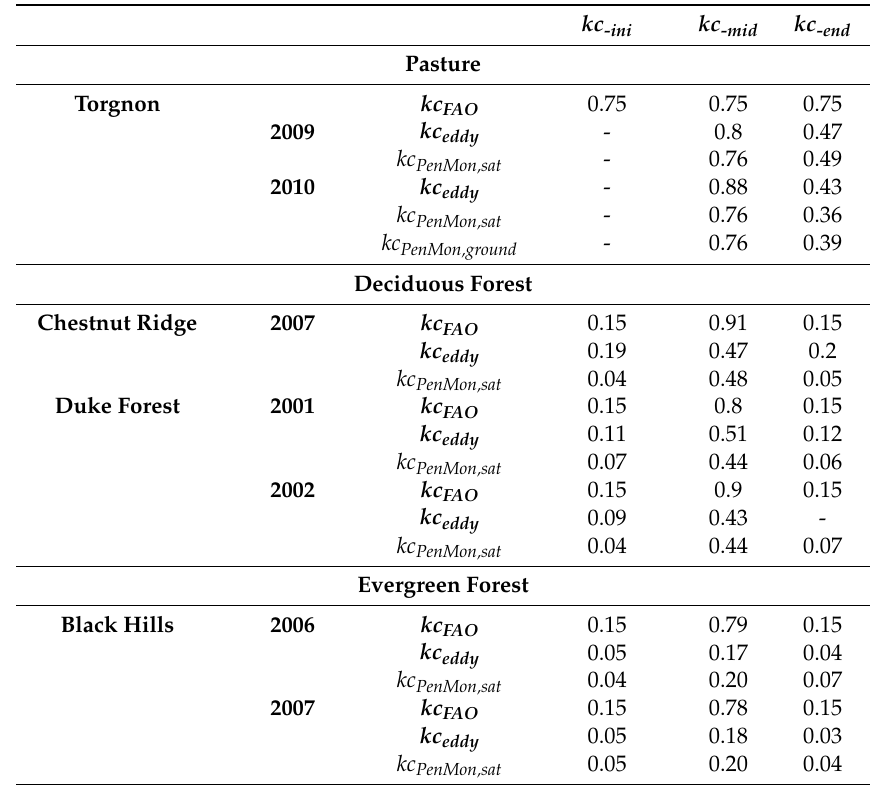
Table 1. Crop coefficient values for the four sites: kc eddy , kc PenMon,sat , kc PenMon,ground , kc FAO .